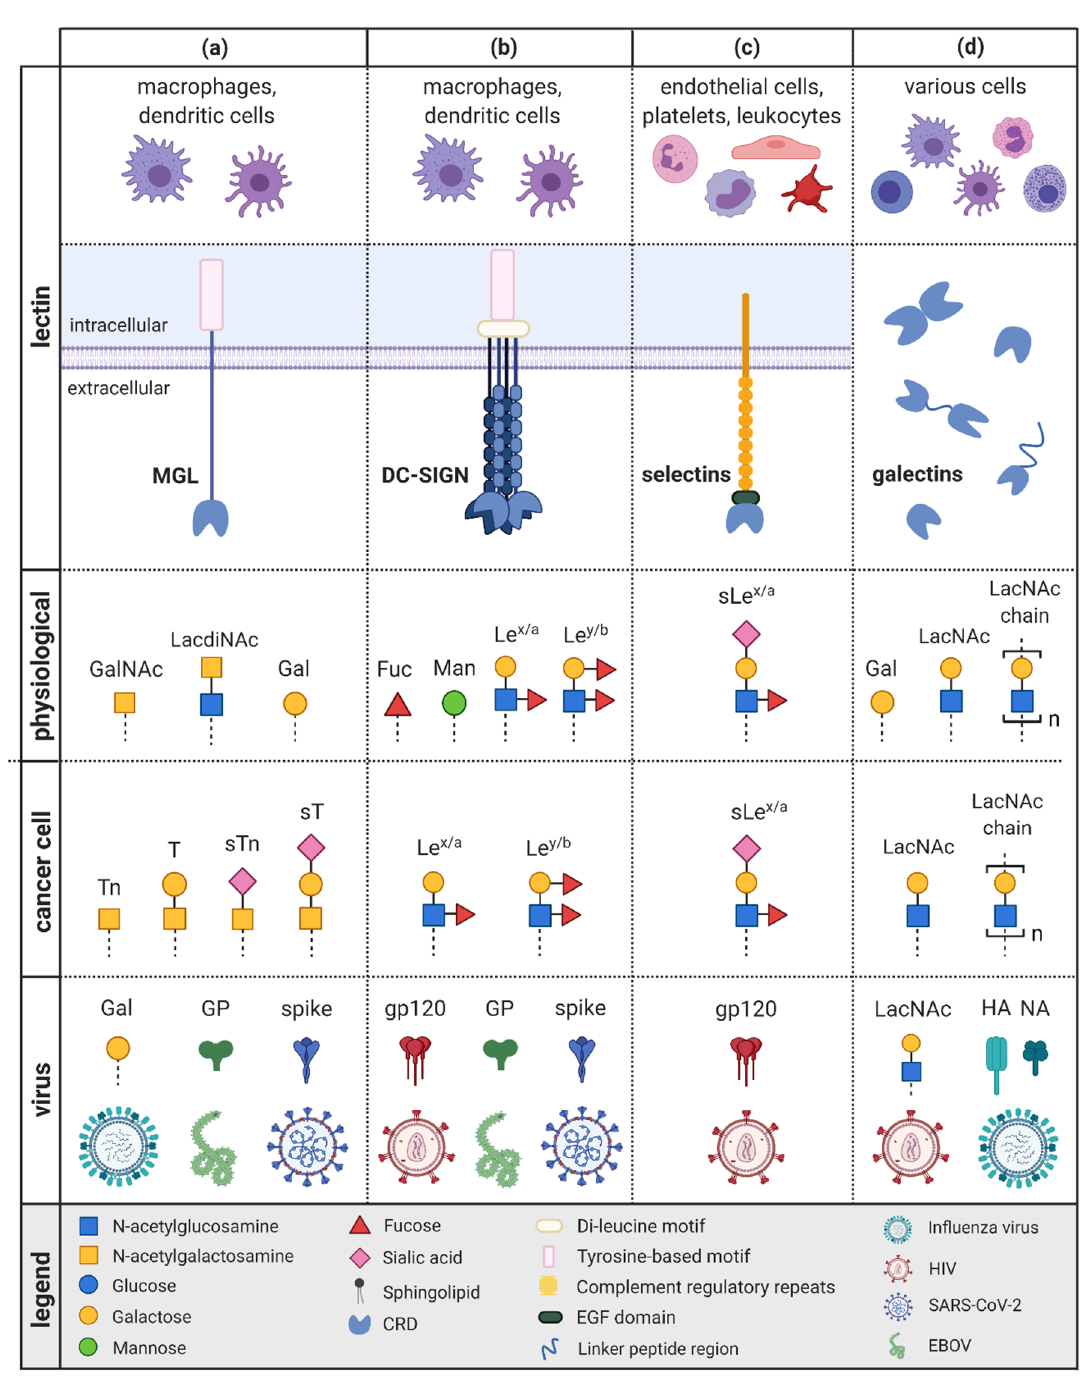
Figure 2. Lectins and their glycan interaction partner physiologically, in cancer and viral infections. The lectin subtypes MGL ( a ), DC-SIGN ( b ), and selectins ( c ) belong to the C-type lectin receptors (CLRs) and consist of a carbohydrate recognition domain (CRD) at the end of their extracellular domain as well as a transmembrane and a cytoplasmatic tail. Galectins ( d ) structurally possess one or two CRDs and, in part, a non-CRD domain or a linker peptide region. ( a ) MGL is expressed on macrophages and dendritic cells and physiologically binds galactose-terminated glycans and N -acetyl-galactosamine (GalNAc). In cancer, MGL